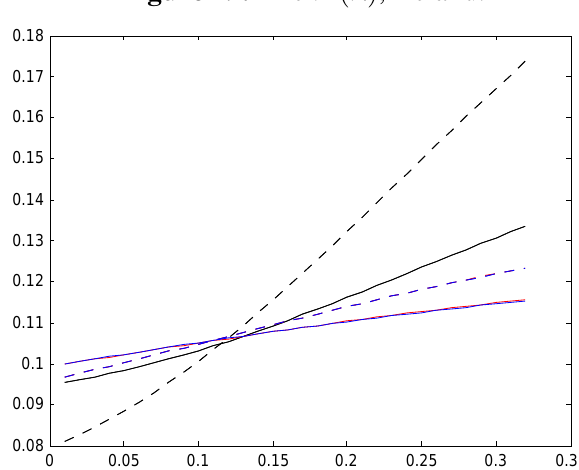
Figure 20. The r ∗ ( λ ) , Italy.